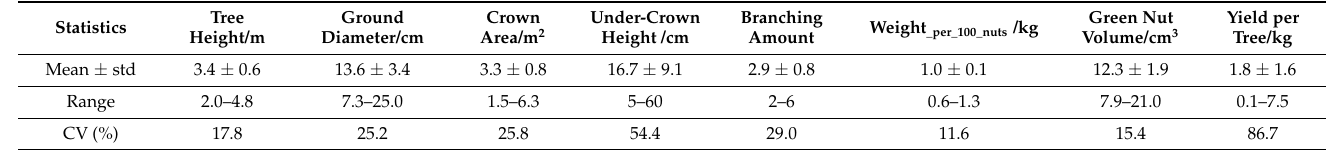
Table 1. Basic statistics for morphological and green nut yield traits of Chinese